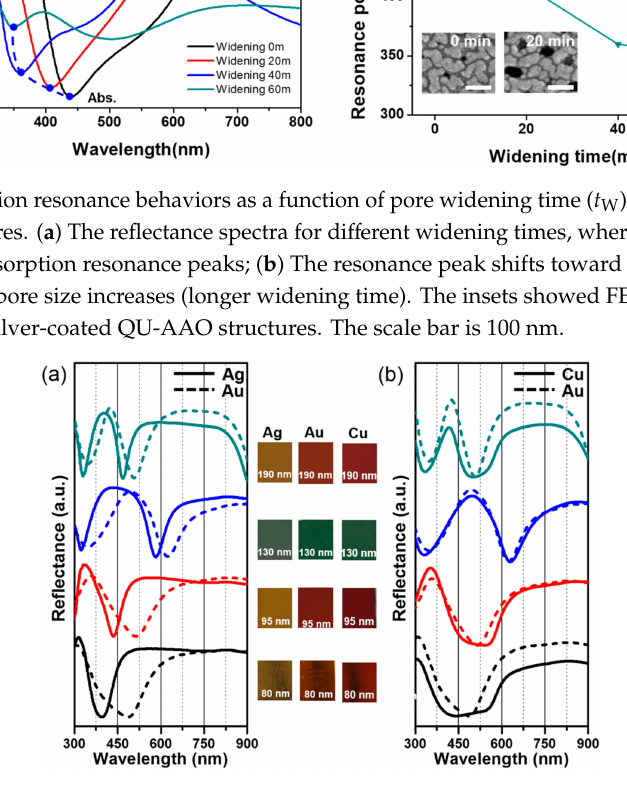
Figure 7. Comparison of three coating materials: Gold (Au), silver (Ag), and copper (Cu). ( a ) Optical reflectance spectra and photographs at di ff erent alumina thickness are plotted for the comparison between the QU-AAO coated with Au (dashed lines) and Ag (solid lines). The absorption bands of Ag occur at shorter wavelength of ~100 nm relative to Au and the di ff erence becomes smaller as the layer becomes thicker; ( b ) reflectance measurements of Au (dashed lines) and Cu (solid lines) show almost identical optical properties. The graphs are shifted in the y -axis for